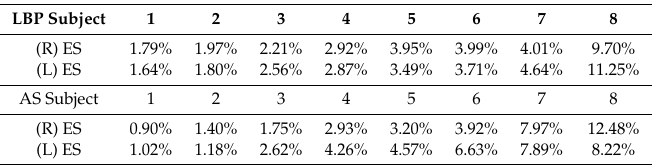
Table 3. The lumbar erector spinae (ES) activity level (percent maximal voluntary contraction, %MVC) during simulated deep squatting position.